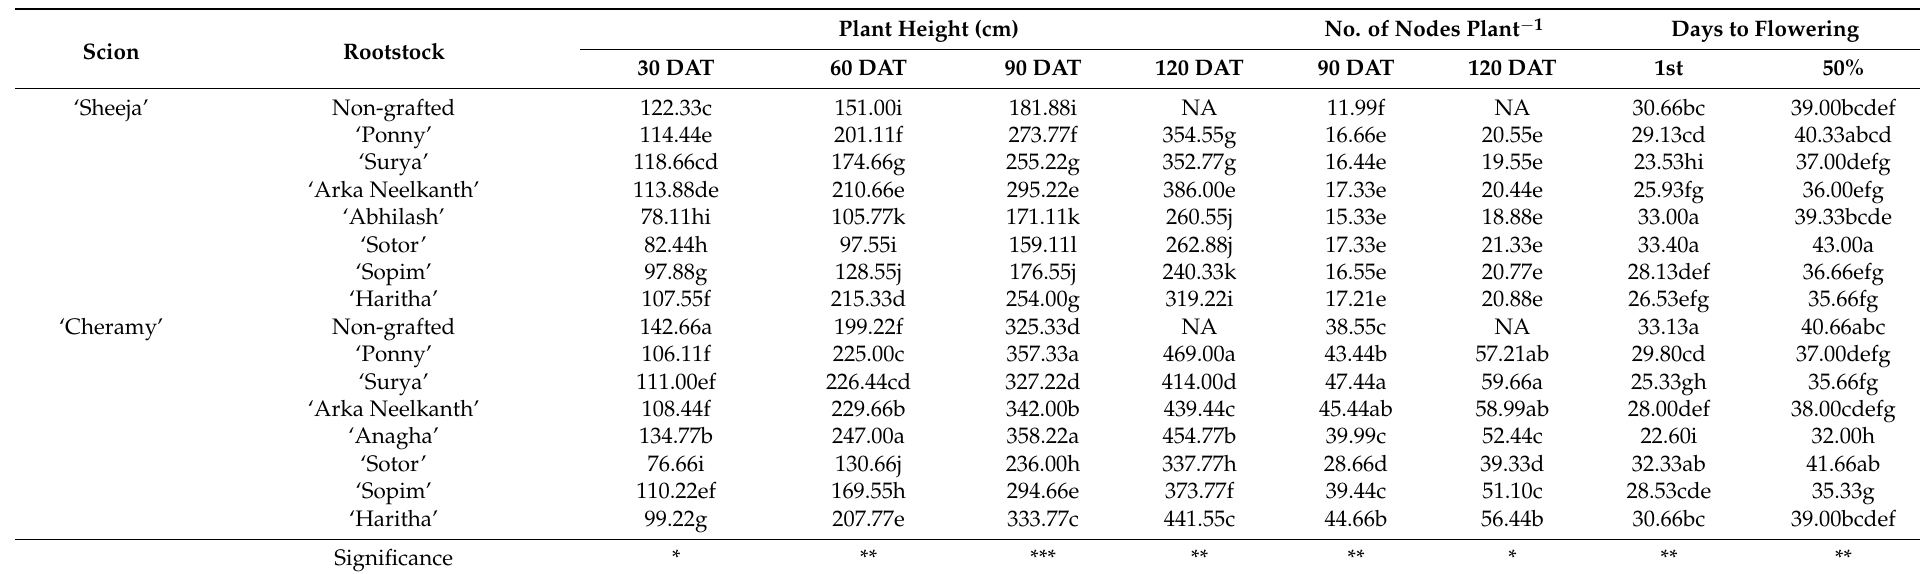
Table 3. Plant height, number of leaves, days to flowering and fruit set in different graft combinations of cherry